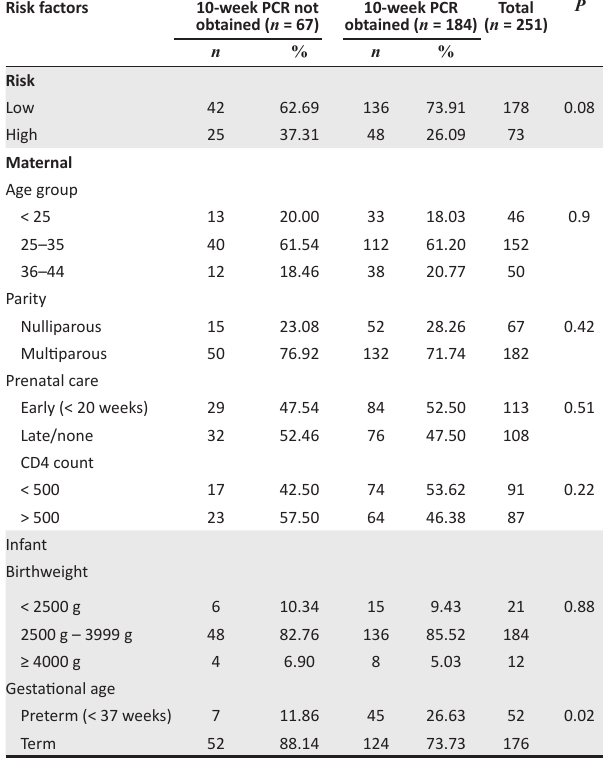
TABLE 3: Maternal and infant risk factors for not obtaining a 10-week polymerase chain